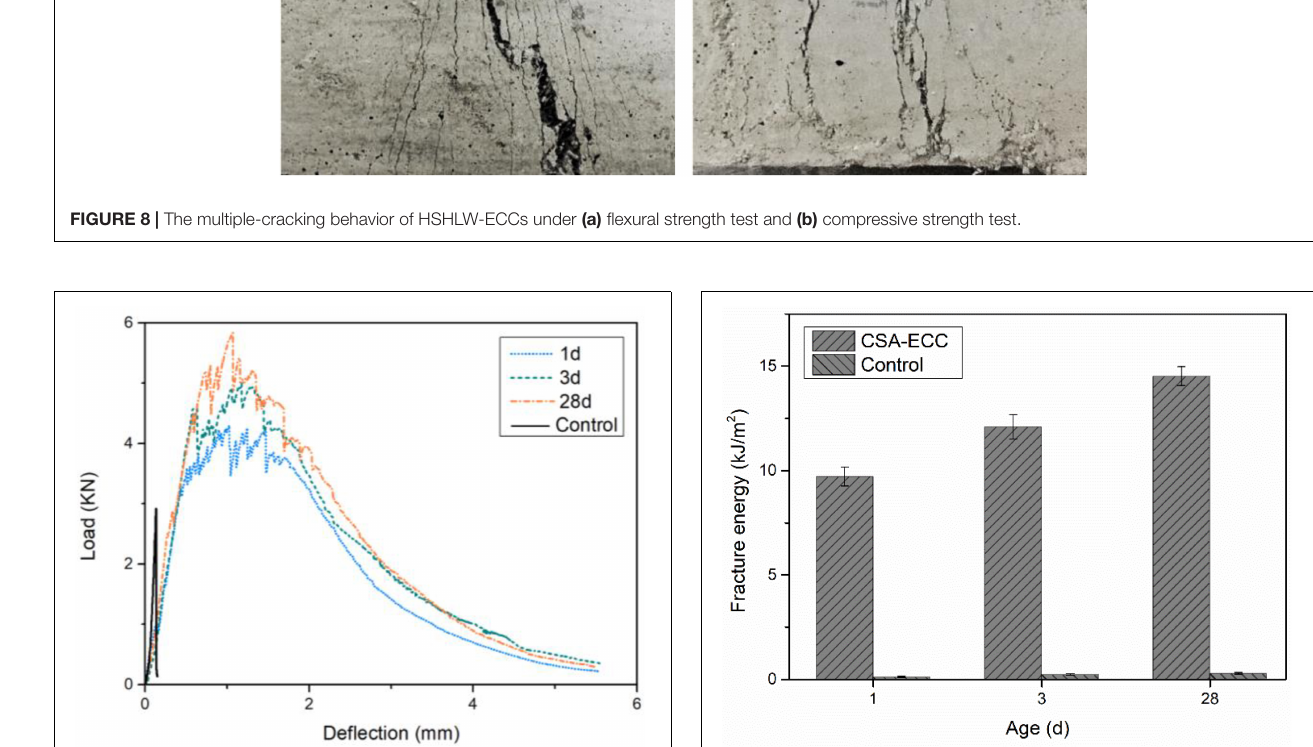
FIGURE 10 | Calculated fracture energy of CSA-ECC and plain CSA specimens (control) after 1, 3, and 28 days of